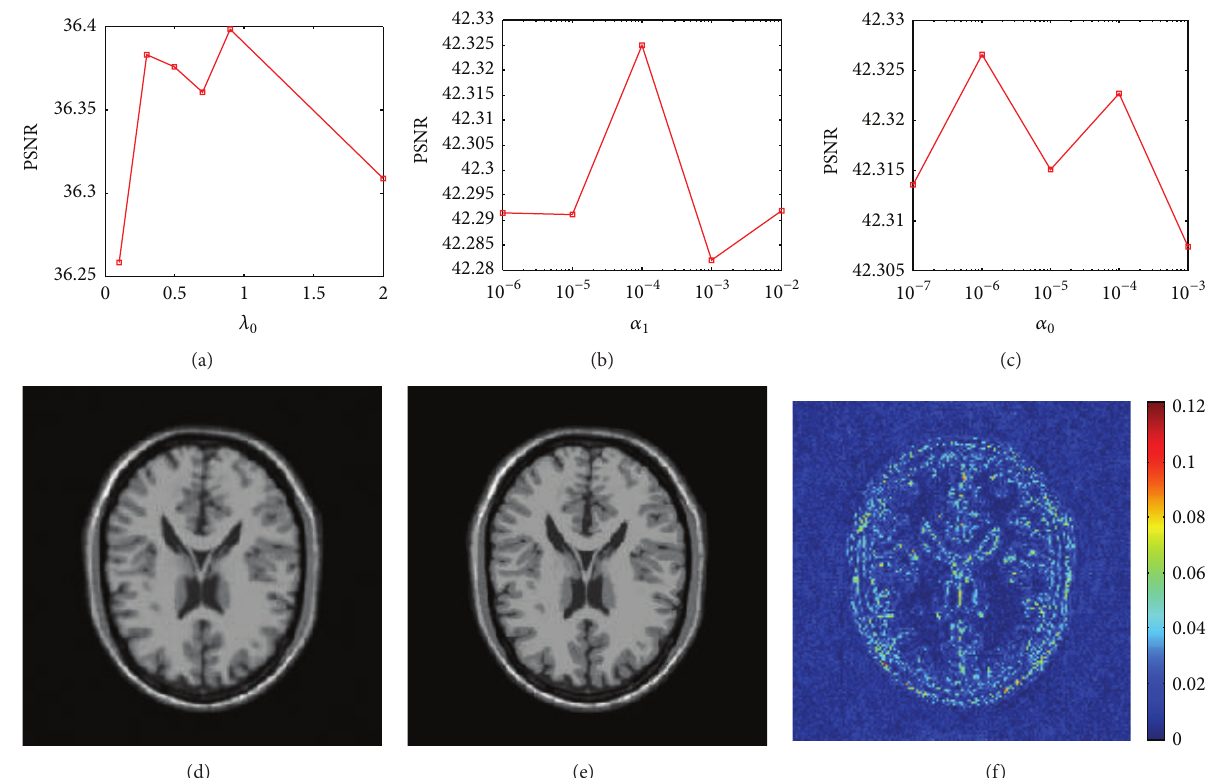
Figure 4: Parameter evaluation. (a) PSNR versus 𝜆 0 . (b) PSNR versus 𝛼 1 . (c) PSNR versus 𝛼 0 . (d) The reference image. (e) Reconstructions with 𝜆 0 = 0.9 , 𝛼 1 = 10 −4 , and 𝛼 0 = 10 −6 . (f) The reconstruction errors of (e).